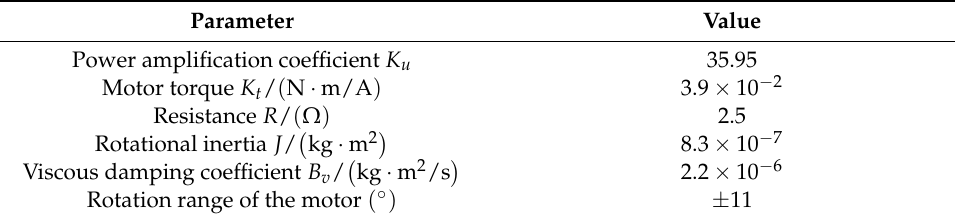
Table 2. Parameters of the experimental